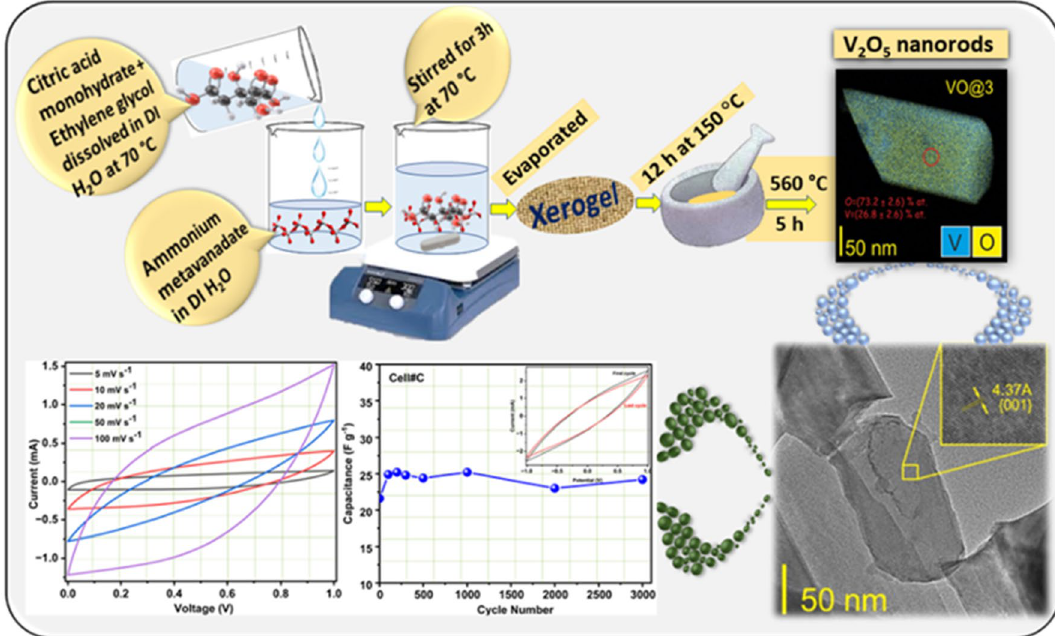
Figure 1. Schematic representation of the V 2 O 5 nanorods preparation using different chelating